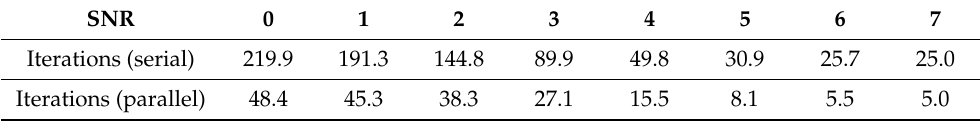
Table 2. Average complexity on the (47,24) QR